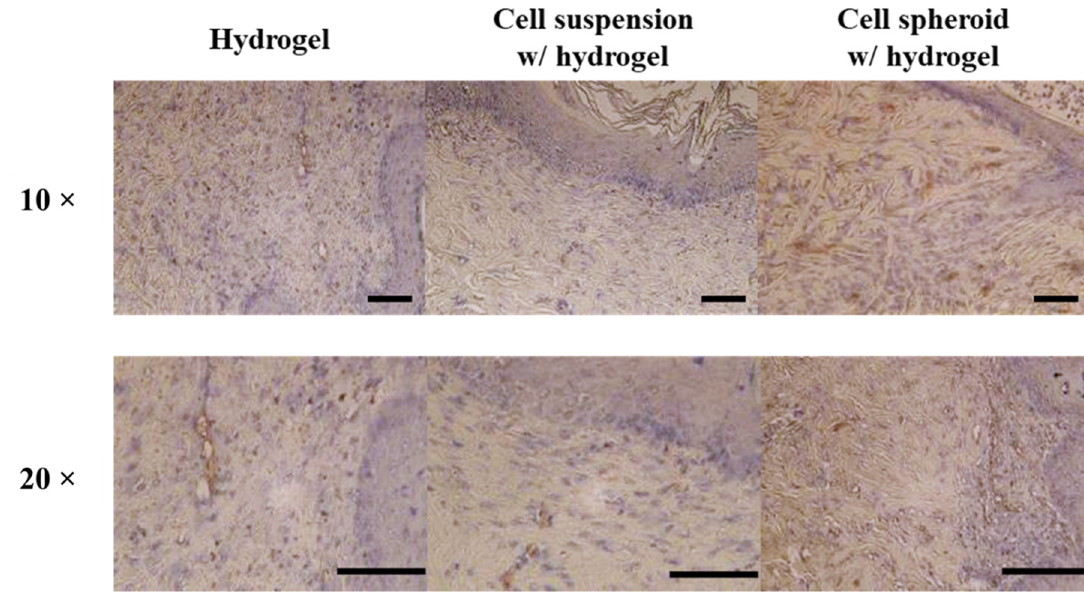
Figure 5. Representative photographs of the angiogenesis state in the wound area and immunohistochemistry staining (brown: CD31) at the wound healing region 14 days after treatment. Scale bar: 200 μ m.